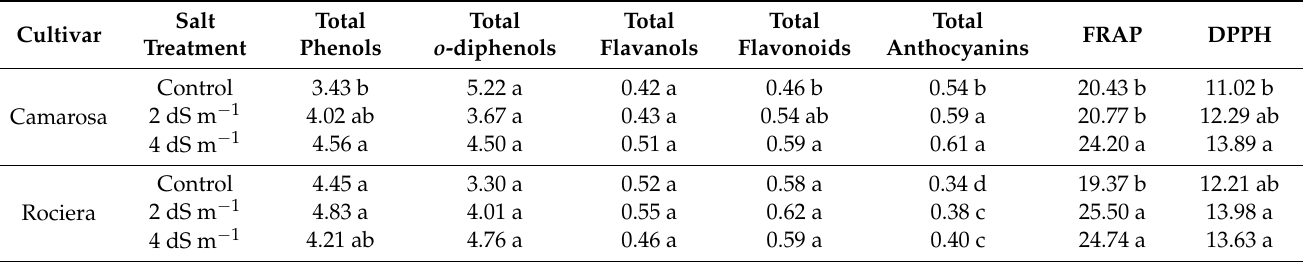
Table 6. Effect of salt stress on strawberry fruit total phenols, total o -diphenols, total flavanols and total flavonoids concentration (expressed as mg g − 1 fresh weight), total anthocyanins (expressed as mg g − 1 fresh weight) and antioxidant capacity of strawberry fruit juice, according to FRAP and DPPH assays (expressed as µ mol Trolox g − 1 fresh weight).